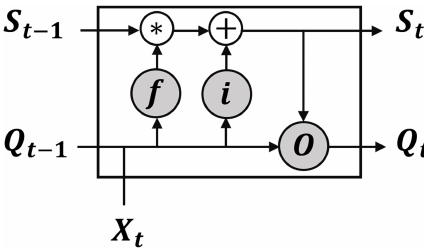
Figure 2. Structure of the long short-term memory (LSTM) cell, modified from (Kratzert et al.,